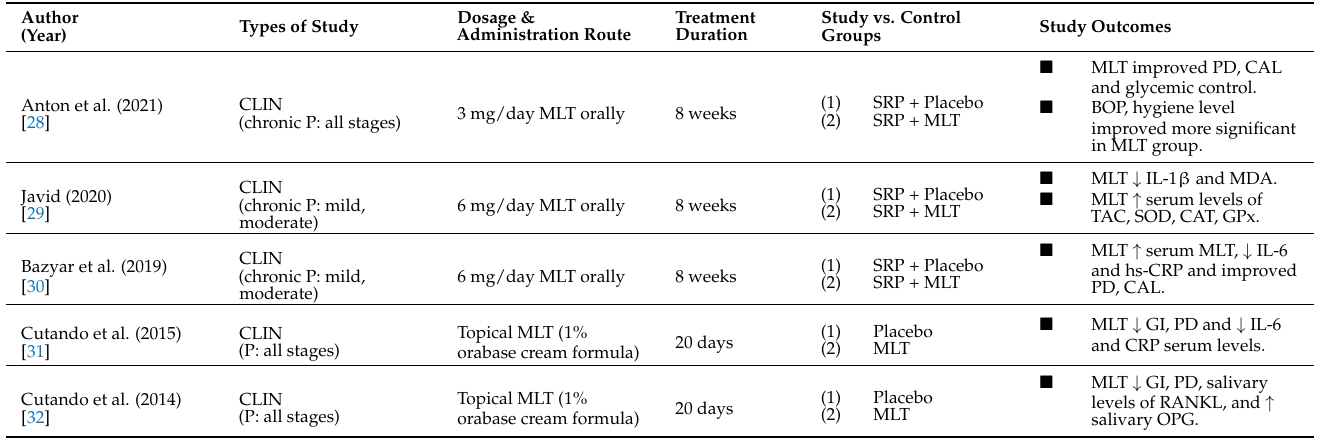
Table 4. Studies on the use of melatonin (MLT) in diabetes-associated periodontitis